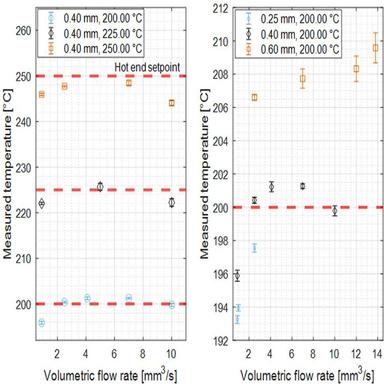
Measured temperature versus volumetric flow rate for varying hot end temperature setpoints with the 0.40 mm nozzle (left) and measured temperature versus volumetric flow rate for varying nozzle orifice diameters at a hot end temperature setpoint of 200 ◦C (right). The error bars represent one standard deviation of the measured temperature.